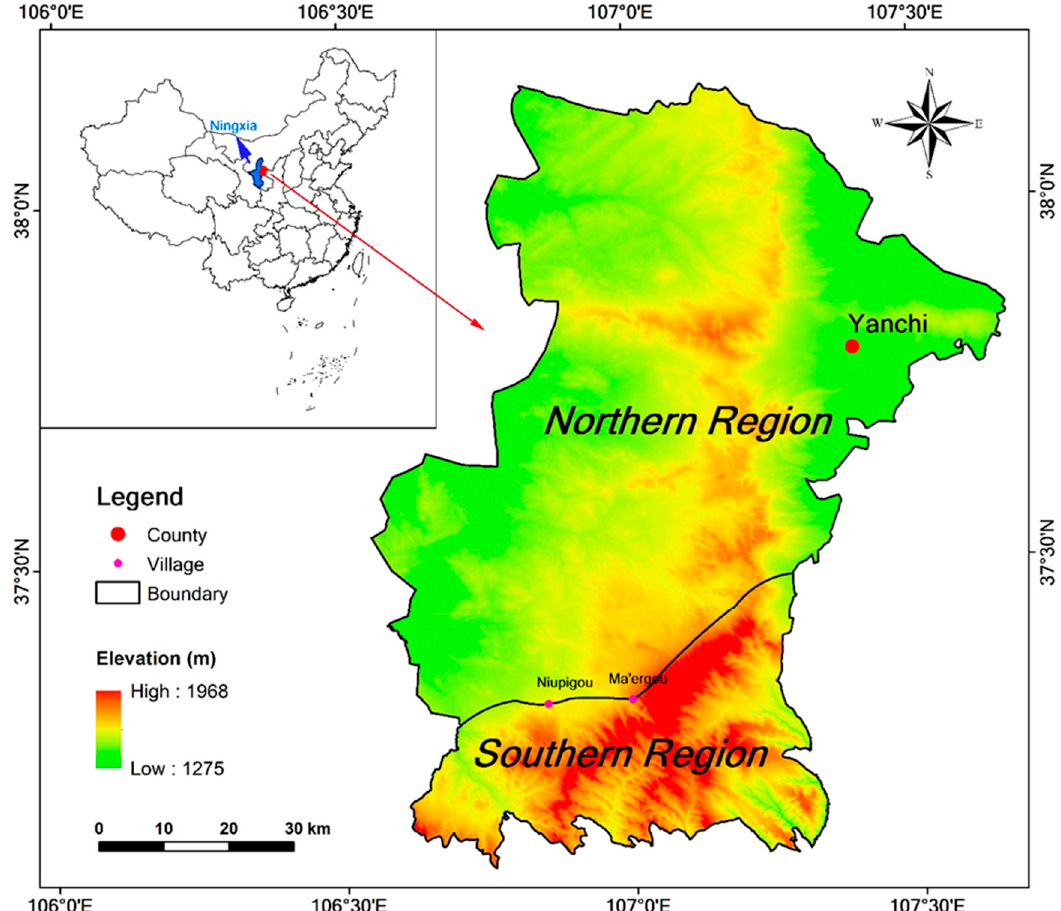
Figure 2. Location of Yanchi County. Ma’ergou and Niupigou are two villages in the boundary between the northern and southern region.